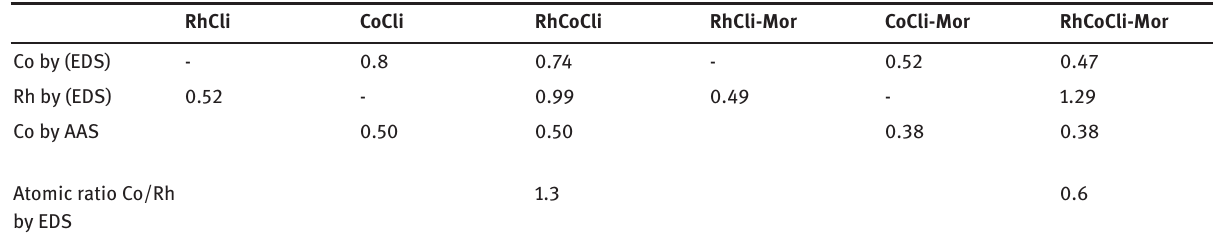
Table 4: Comparison between the Co and Rh chemical analysis EDS (surface) and AAS (bulk), for mono and bimetallic catalysts (precursors heated at 500 o